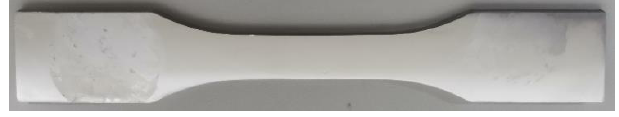
Figure 2. Smooth specimen after being grinded and polished.